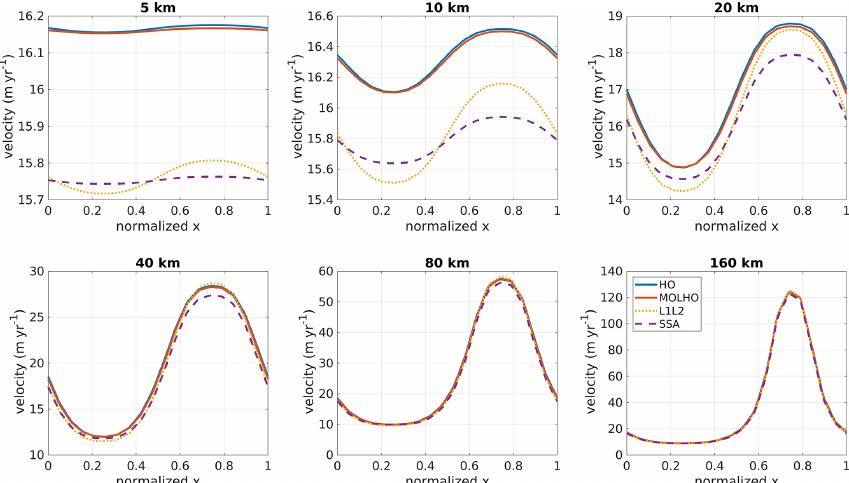
Figure 2. ISMIP-HOM experiment C: surface velocity at y = 0 . 25 L for different wavelengths, L , obtained with the three-dimensional higher-order model (HO) and with the two-dimensional MOno-Layer Higher-Order (MOLHO) model. Results obtained with L1L2 and shelfy stream approximation (SSA) models are also shown. The surface velocity is computed by taking the Euclidean norm of the horizontal (cid:113) v 2 x + v 2 y ). We employ 20 vertical layers for the HO model. velocities at the ice surface (i.e.,